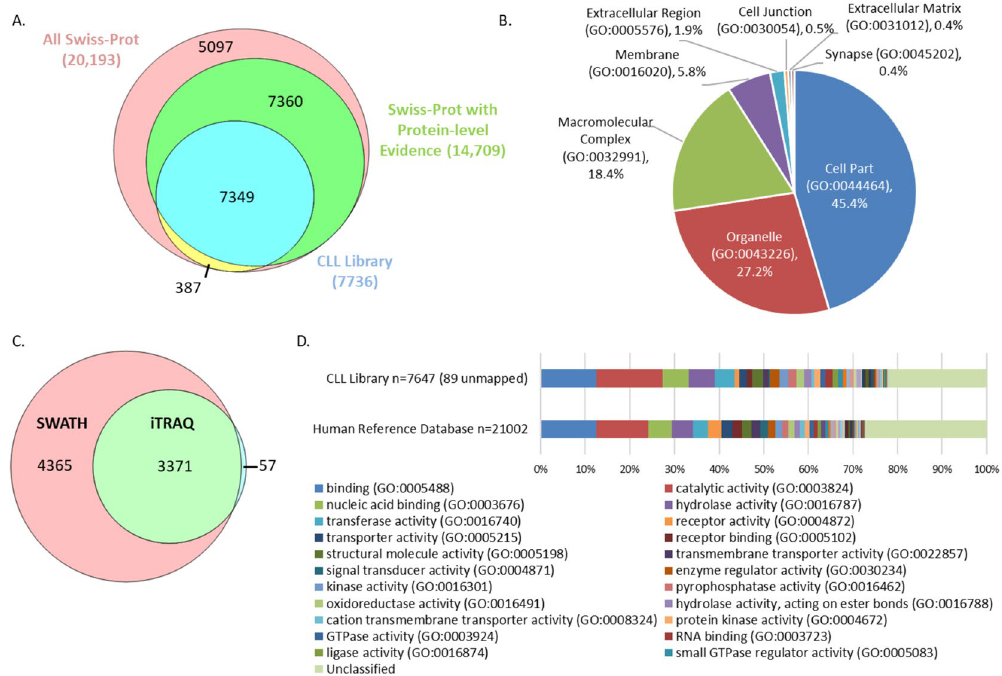
Figure 1. Representation of proteins in CLL-specific spectral library. ( A ) Representation of proteins from the CLL library (n = 7736) in the UniProtKB/Swiss-Prot Human database, showing coverage of 50% of entries with evidence at the protein level. ( B ) GO cellular components of proteins represented in the CLL library showing the known cellular location for 5499 entries. ( C ) Overlap of proteins identified in our previous iTRAQ study 7 and represented in the CLL library. The CLL library includes 99% of the proteins identified in our previous study and expands coverage of the CLL proteome by 127%. ( D ) Proteins represented in the CLL library with known GO Molecular Functions (n = 7647) compared with representation from entries in the reference Homo sapiens gene database (n =